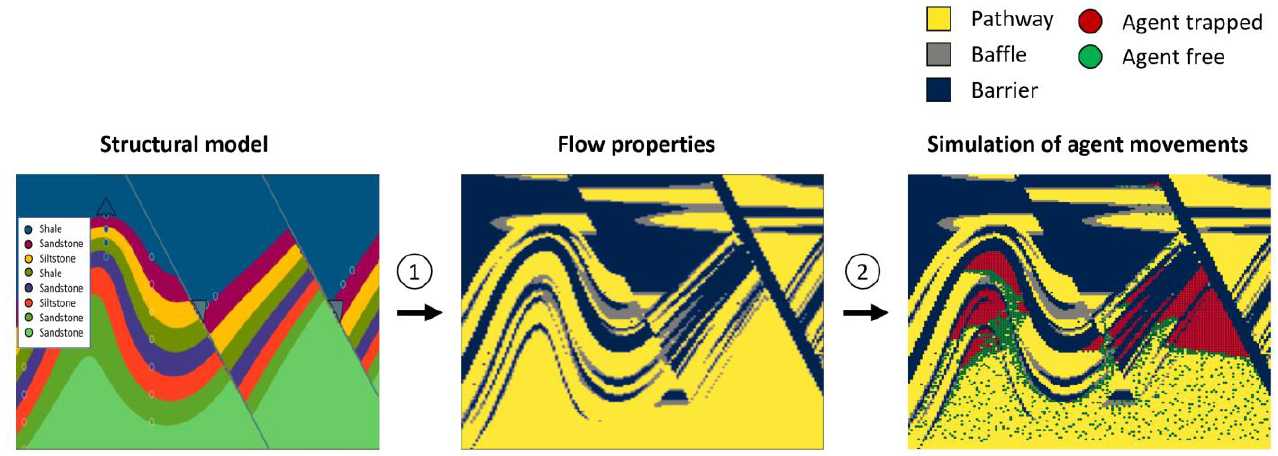
Figure 2. Setup of the simulation workflow for geomodels in Python: a structural model is first built with GemPy [55,56]. The model is then populated with different facies types with the help of PyKrige [57,58], and afterwards, hydrocarbon simulation is performed with Go with the Flow .